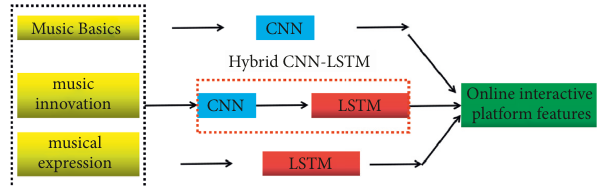
Figure 1: Scheme design of deep neural network technology in music teaching effect